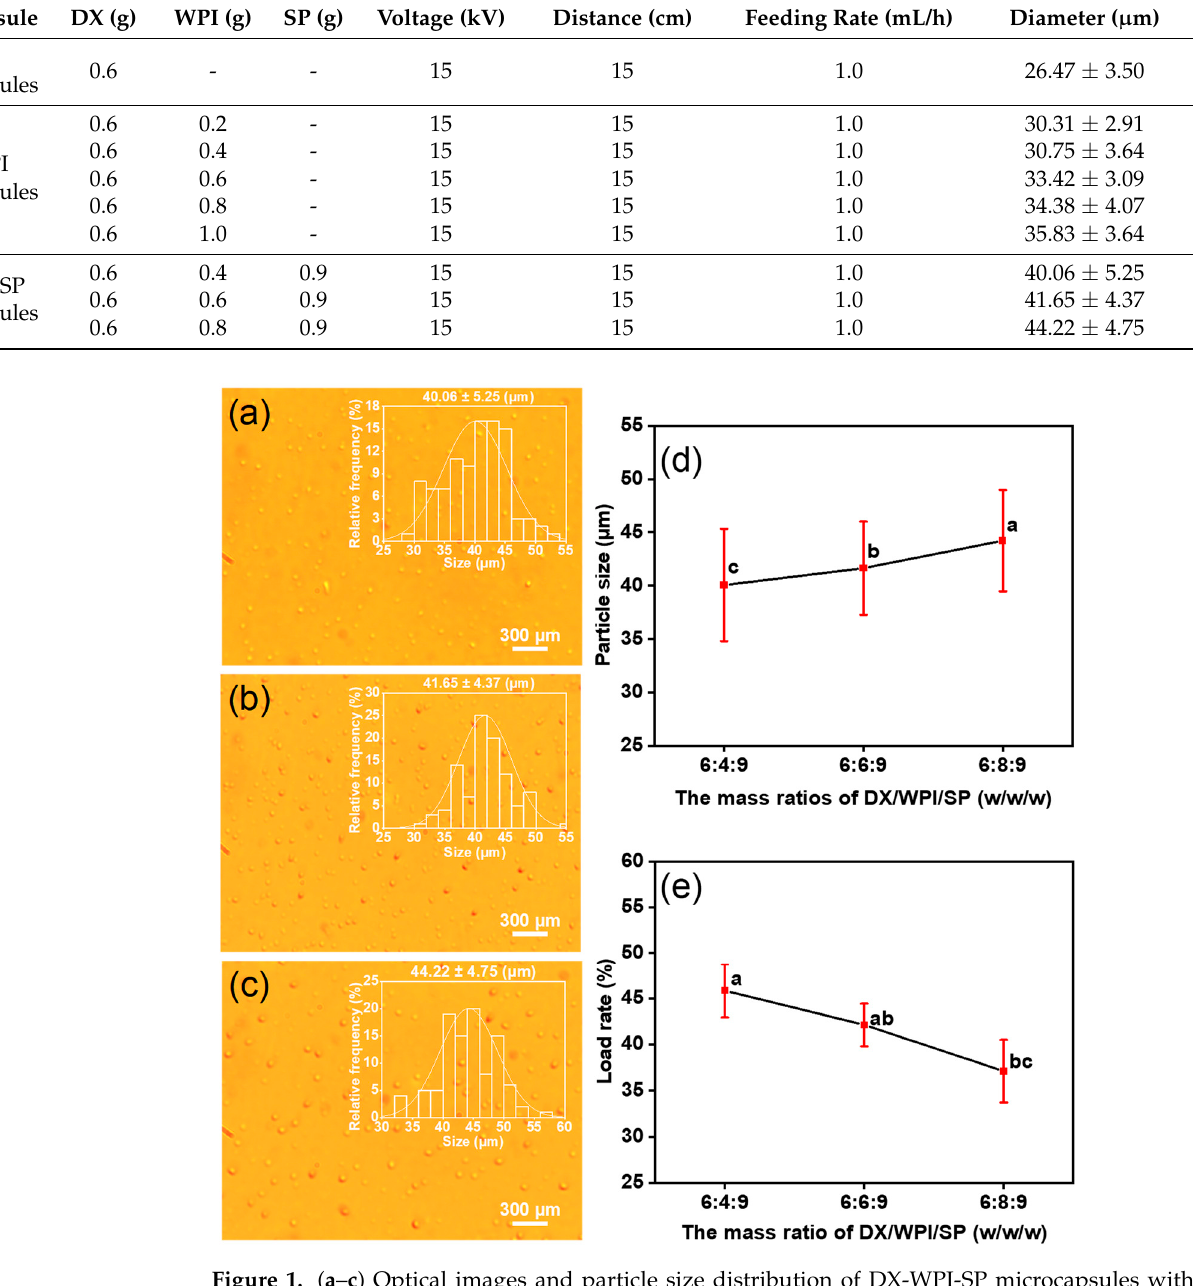
Figure 1. ( a – c ) Optical images and particle size distribution of DX-WPI-SP microcapsules with dif-